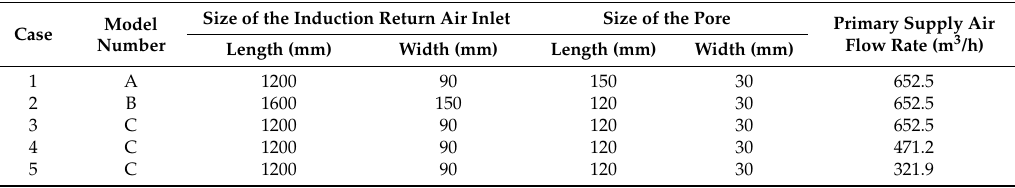
Table 1. The parameters of the supply air and the model of the RIDU.